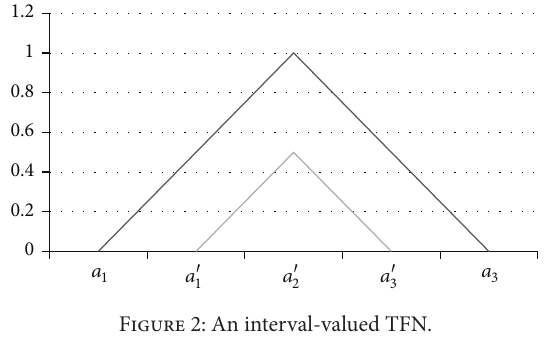
Figure 2: An interval-valued TFN. Table 2: Corresponding TFNS for linguistic preferences. Linguistic preferences Interval-valued TFNS